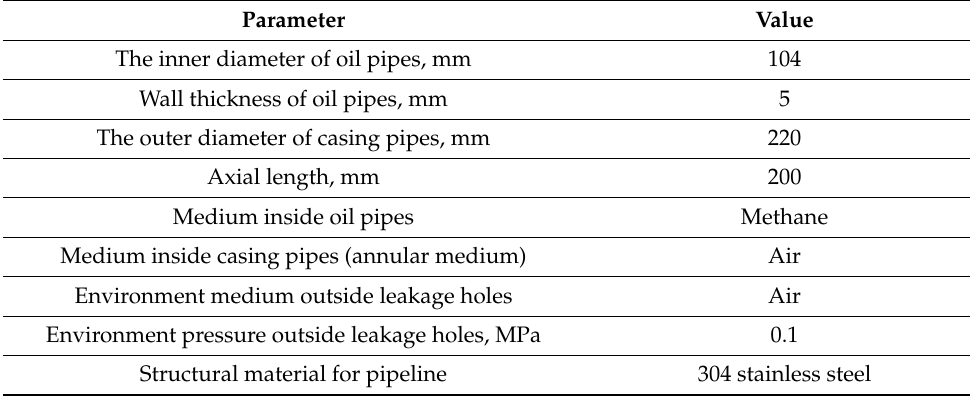
Figure 1. Schematic of micro-leakage of casing pipes. Table 1. Parameter table of the physical model.